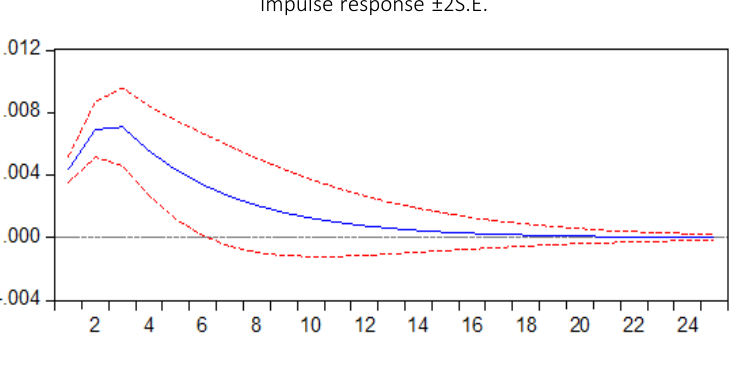
Impulse response ±2S.E.